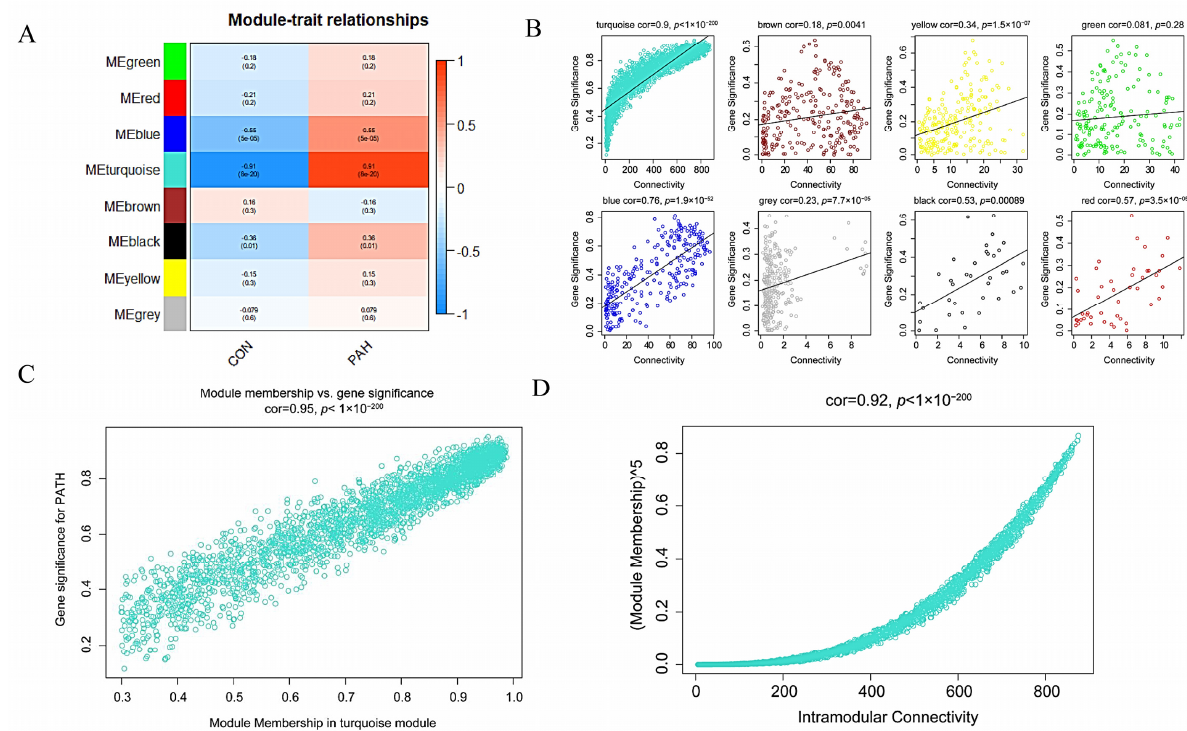
Figure 5. Identification of the key module. ( A ) Correlations between the gene module and PAH. ( B ) Scatterplot of connectivity versus GS for PAH of each module. ( C ) Scatterplot of GS for PAH versus MM in the turquois module. ( D ) Scatterplot of IC versus MM in the turquois module. MM, module membership; GS, gene significance; IC, intramodular